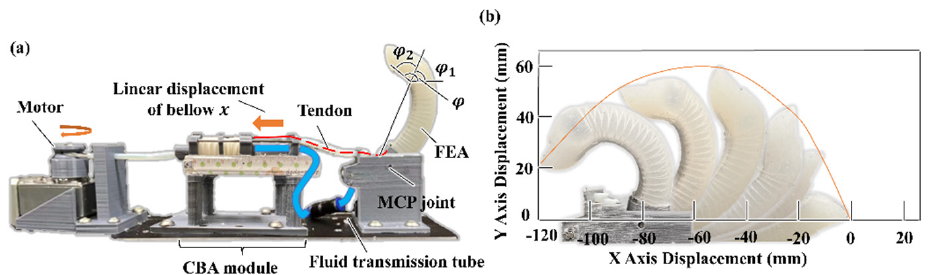
Figure 6. Experimental characterization of the DASA finger. ( a ) Experimental platform. ( b ) Bending trajectory of the DASA finger.